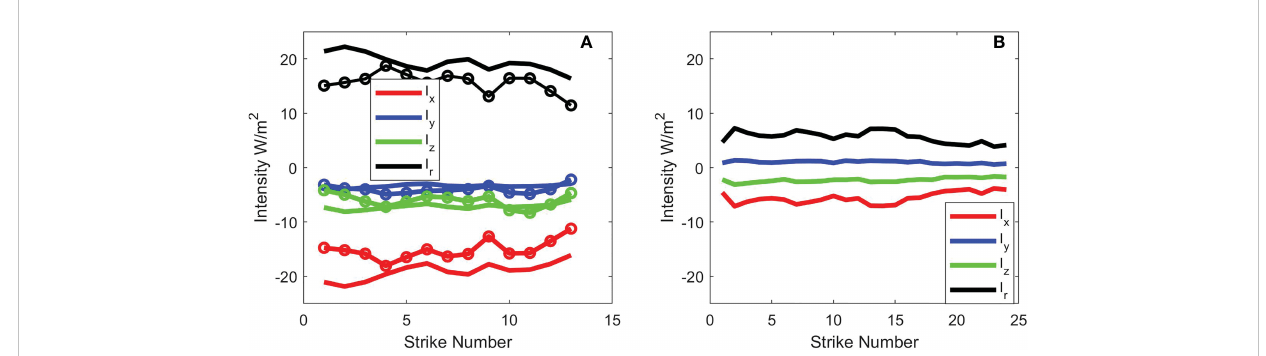
FIGURE 6 (A) Vector intensity Cartesian components I ( x , y , z ) and I r versus strike number n derived from two selected arrival segments of the data from pile T8 n n at a range 10 m (see Figure 4A). First arrival identi fi ed by solid lines, and second (delayed by 9.4 ms) identi fi ed with same color code but with added symbols. (B) Same results corresponding to pile T5 range at 16 m (see Figure 5A), where only the fi rst arrival is